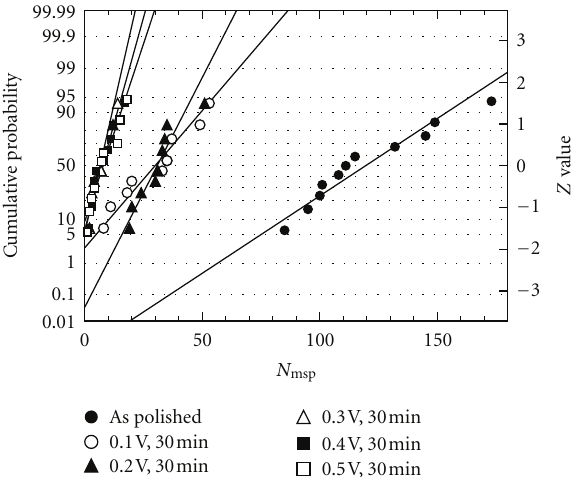
Figure 7: Normal probability plots of the number of metastable pits, N msp , in 0.5M NaCl for commercial Type 316L stainless steels after polarization treatments at di ff erent potentials for 30min in 1M Na 2 SO 4 of pH 3.